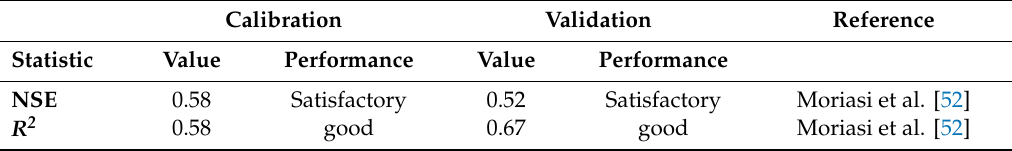
Table 6. Model performance assessment based on daily river discharge, as guided by Moriasi et al. [52].